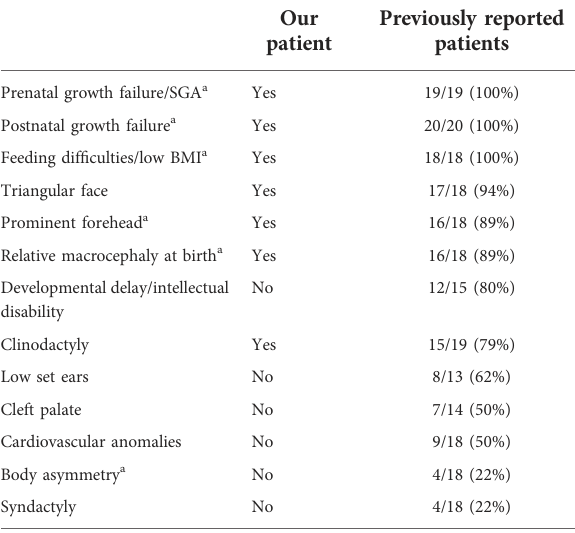
TABLE 1 Clinical characteristics in our patient and patients with previously reported IGF2 variants (6, 8, 11 – 18). Our